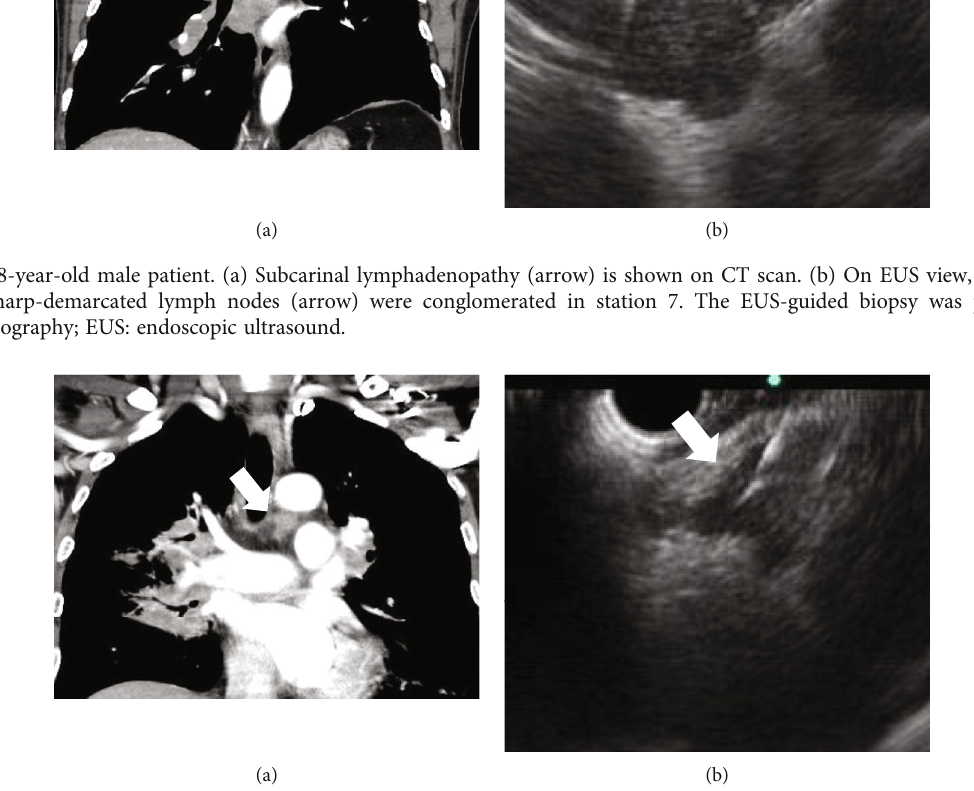
Figure 2: A 53-year-old male patient. (a) Left lower paratracheal lymphadenopathy (arrow) on CT scan. (b) On EUS view, triangle-shaped hypoechoic lymph node (arrow) was observed in station 4L. The EUS-guided biopsy was performed. CT: computed tomography; EUS: endoscopic ultrasound. Table 4: Diagnostic yield for histologic con fi rmation by needle